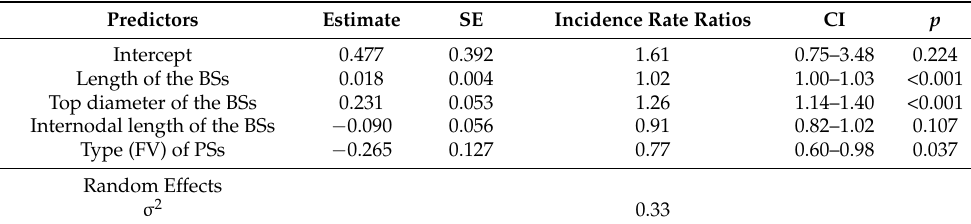
Figure 9. Generalized linear mixed model of the total yield of the bearing shoots (BSs). Note: The higher the incidence rate ratio (>1), the more the yield is positively affected by this variable (black). The lower the incidence rate ratio (<1), the more the yield is negatively affected (gray). Type (FV) of PS, the type of parent shoot. Table 3. Generalized linear mixed model of the total yield of the bearing shoots